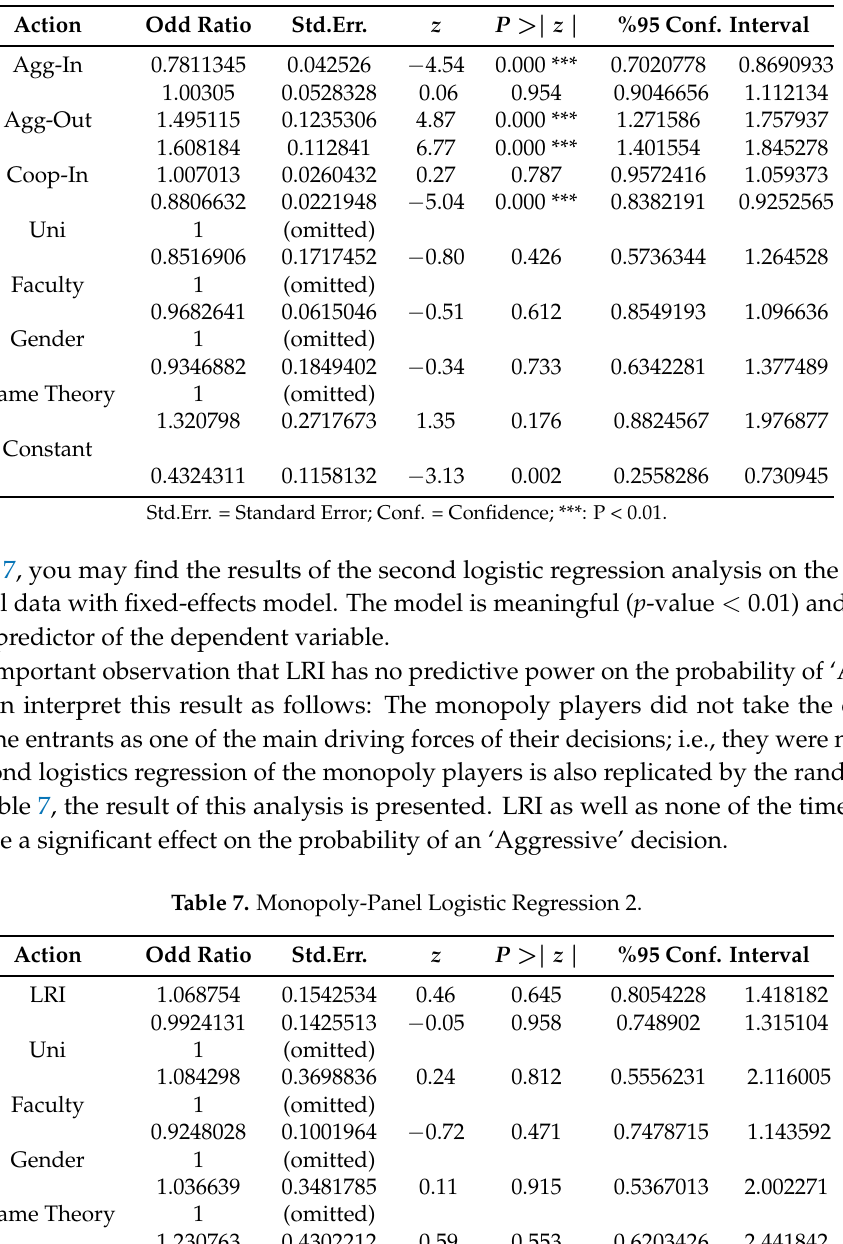
Table 6. Monopoly-Panel Logistic Regression 1.